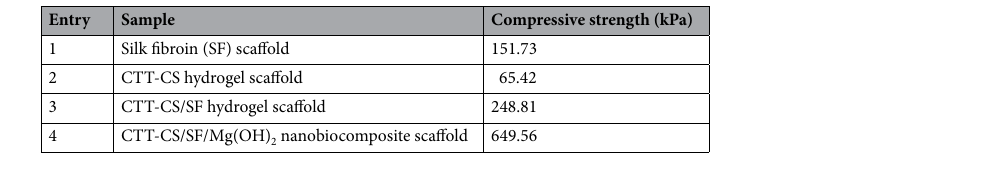
Table 1. Compressive strength of synthesized